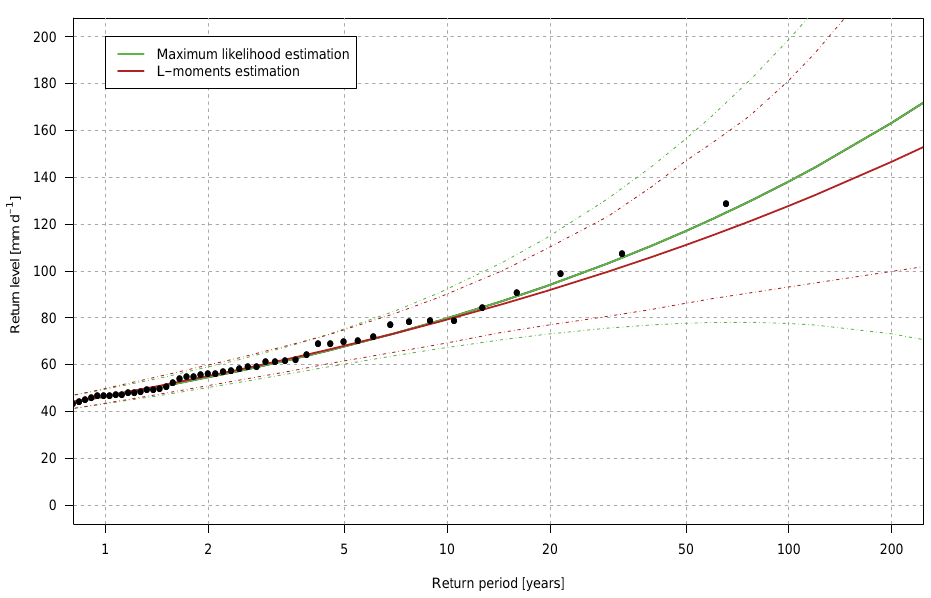
Figure 4. Return level plot of daily rainfall events at Brenner. Return level estimation is based on the block maxima approach with two different parameter estimation methods (MLE and LMOM estimation). Solid lines show the mean estimate, while dashed lines indicate the 95% confidence intervals for the fitted functions.